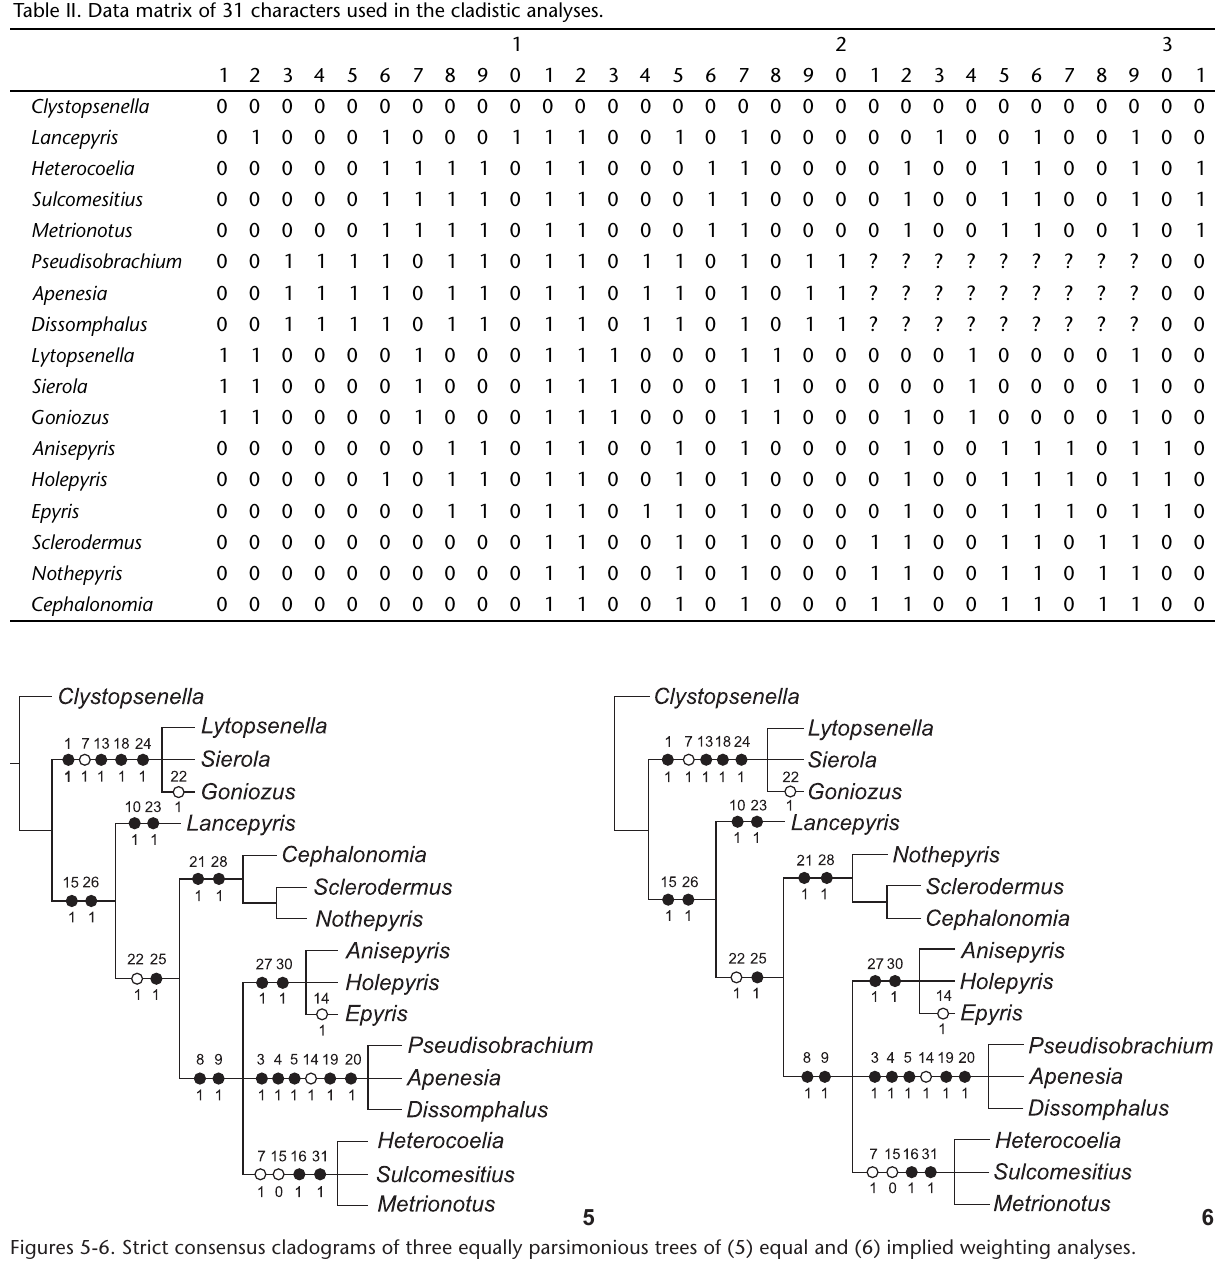
Table II. Data matrix of 31 characters used in the cladistic analyses.